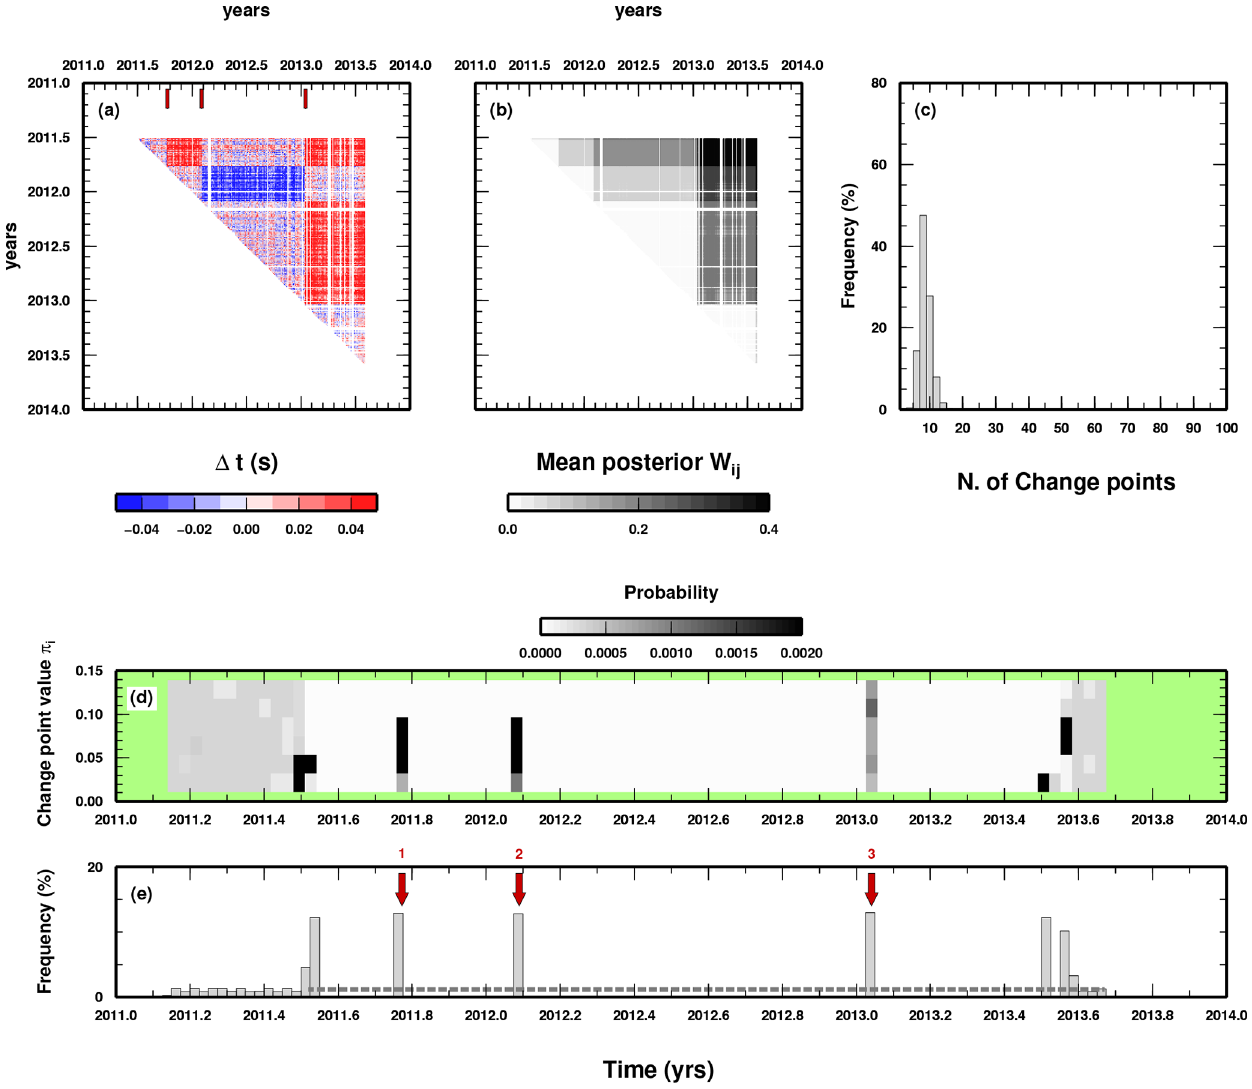
Figure A2. Results of the synthetic test wherein “observed” data have been created with three changepoints. Figure details are the same as in Fig. 5. In panel (a) we show the synthetic data used as input to the